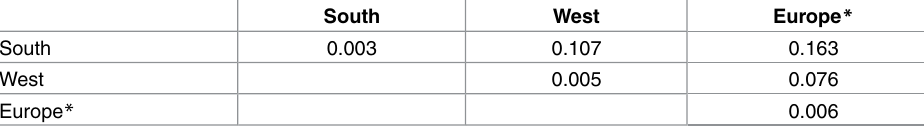
Table 3. Pairwise F ST estimateswithinand